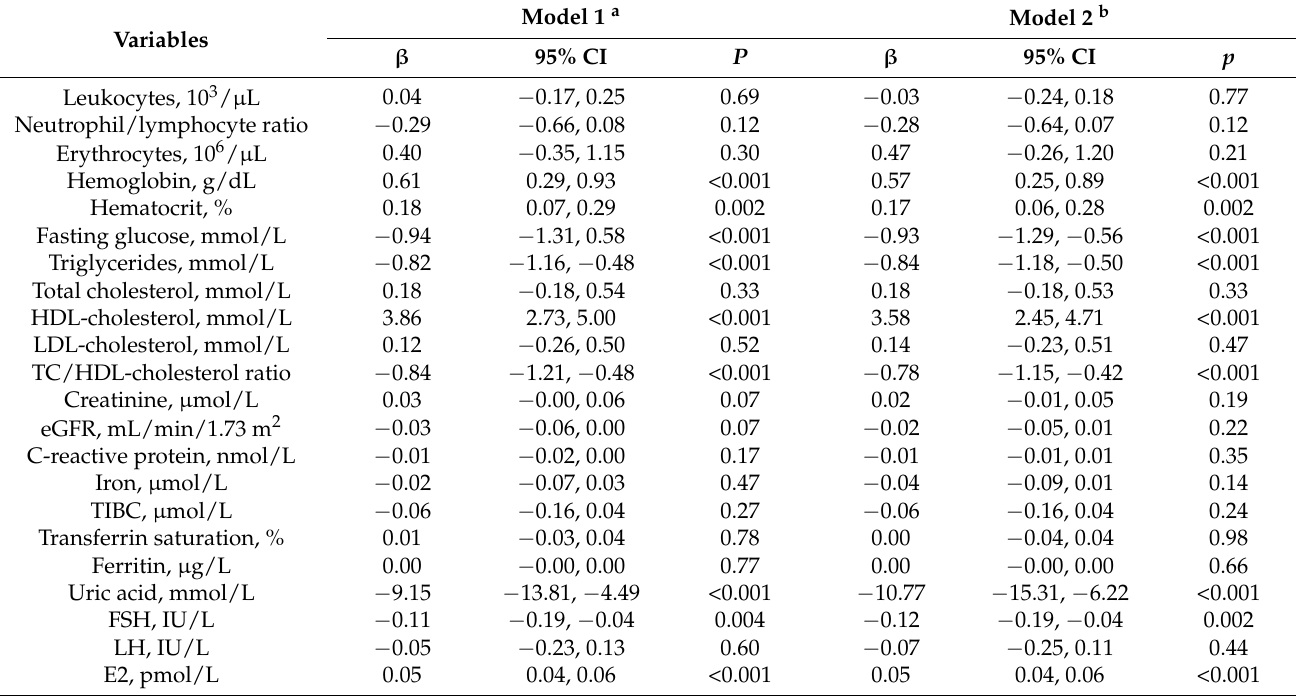
Table 2. Multivariable linear regression of serum testosterone with biochemical